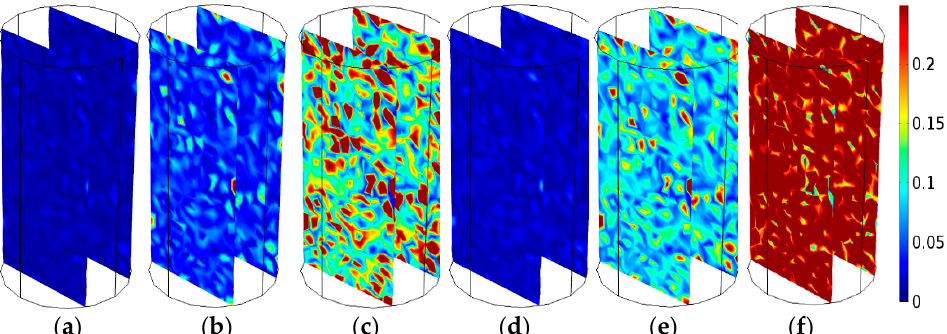
k = 2, T = 75 °C): ( a ) pH w